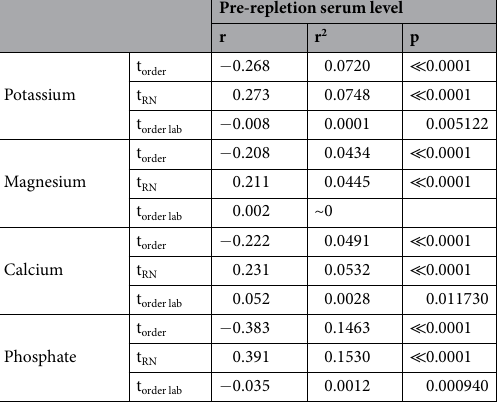
Table 2. Correlation between pre-repletion lab value and time to perform certain